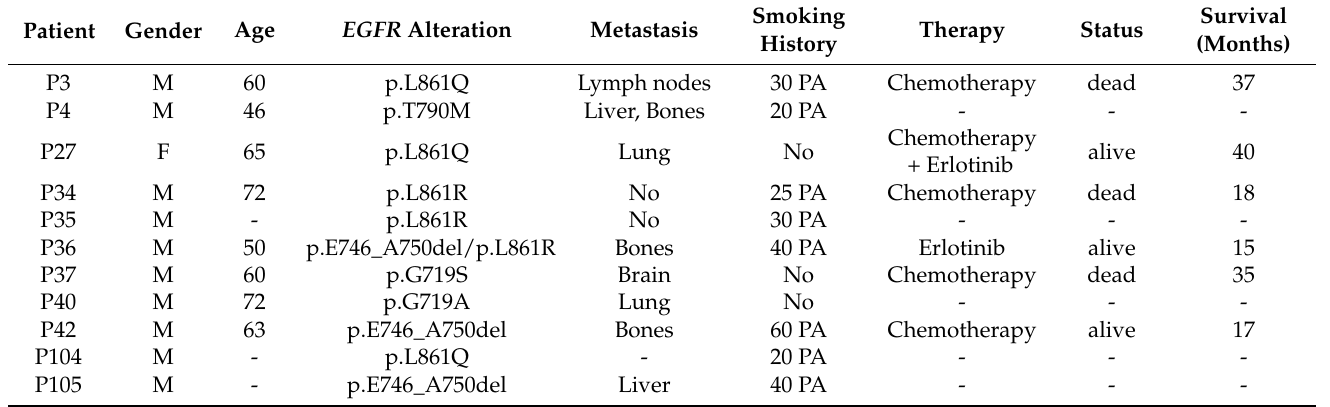
Table 2. Identified mutation in exons 18–21 of the EGFR in Tunisian NSCLC patients.